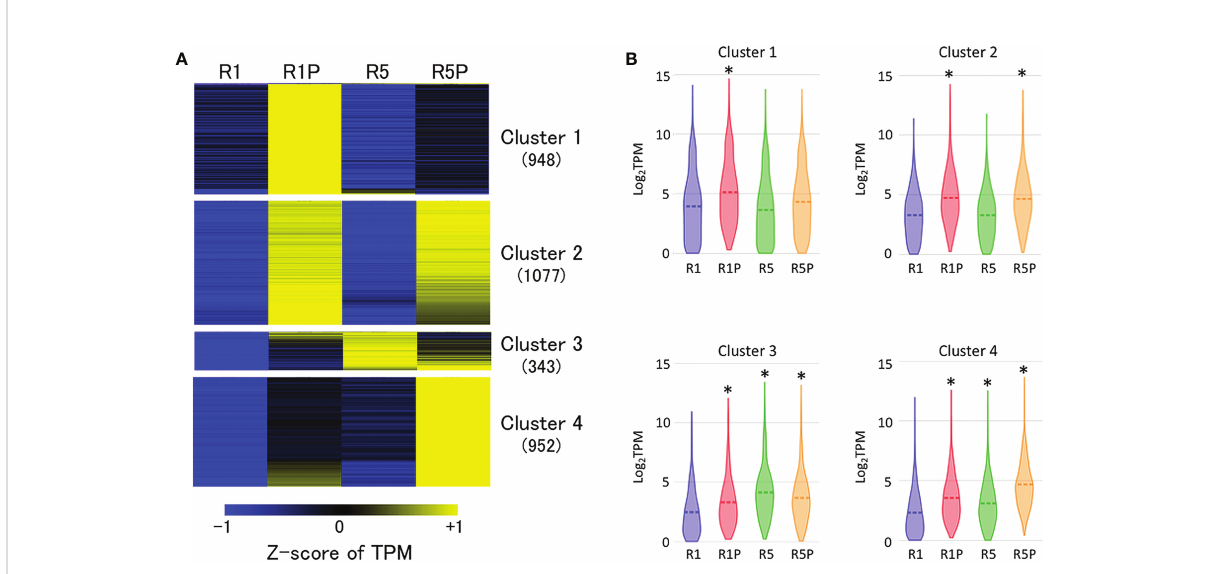
FIGURE 2 Expression patterns of genes induced by PEG treatment. (A) K-means cluster analysis of 3,337 genes whose expression is signi fi cantly up- regulated at R1P compared to R1 (adjusted P < 0.05; Benjamini – Hochberg method, log 2 fold change > 1). The number in the parentheses indicates the number of genes in each cluster. Z-score of TPM values was used to normalize each gene expression level. (B) Violin plots showing log